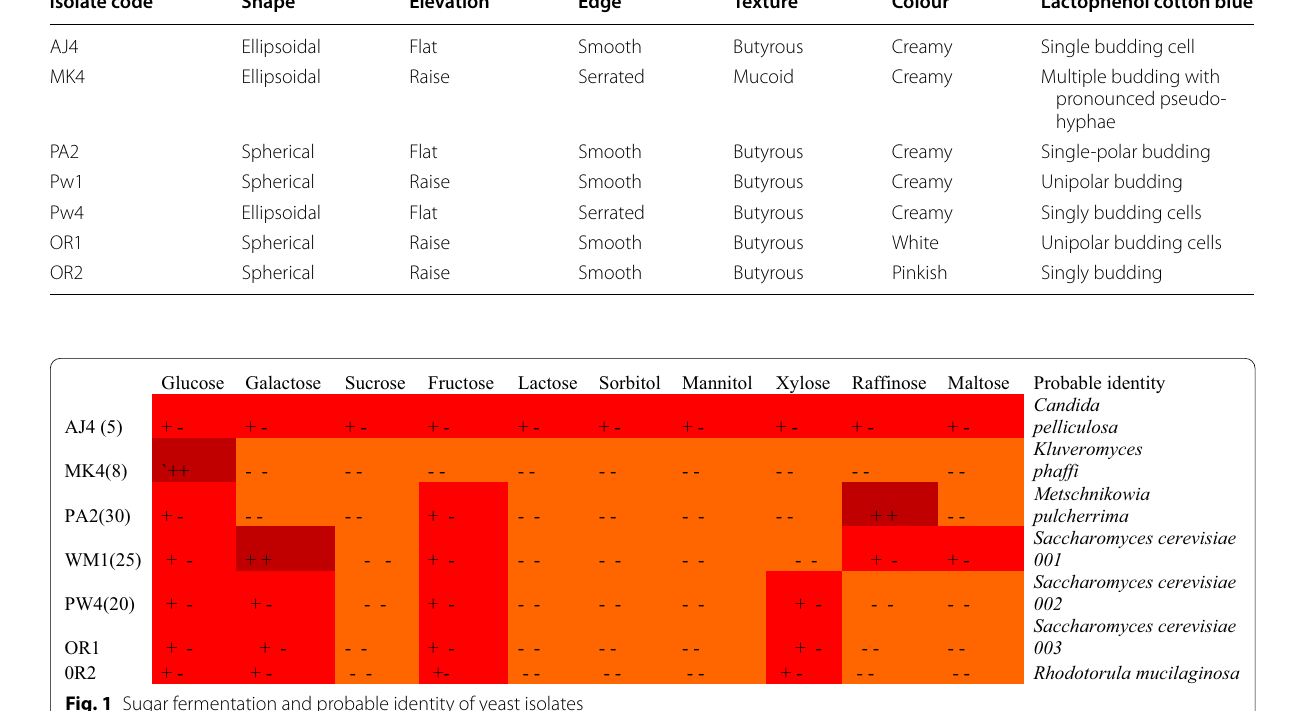
Table 3 Microscopic morphological appearance of the yeast isolates Isolate code